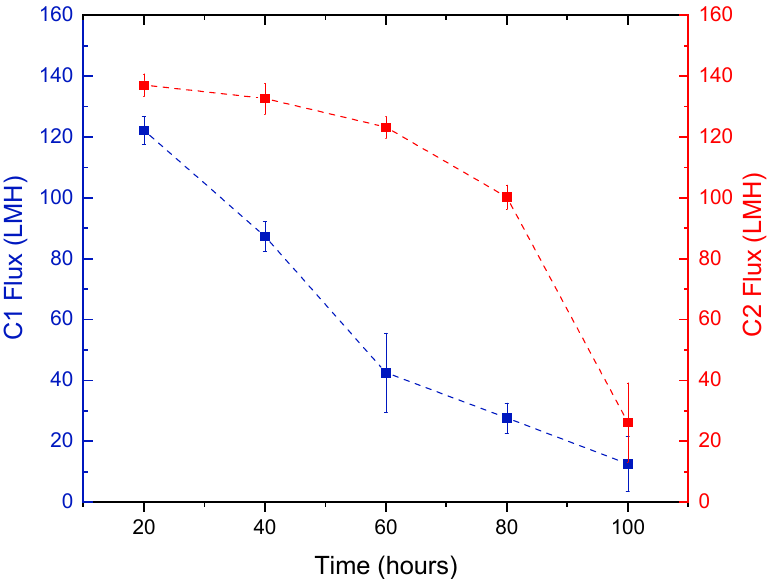
Figure 8. The effect of brine concentration on the permeate flux at longtime DCMD operations.